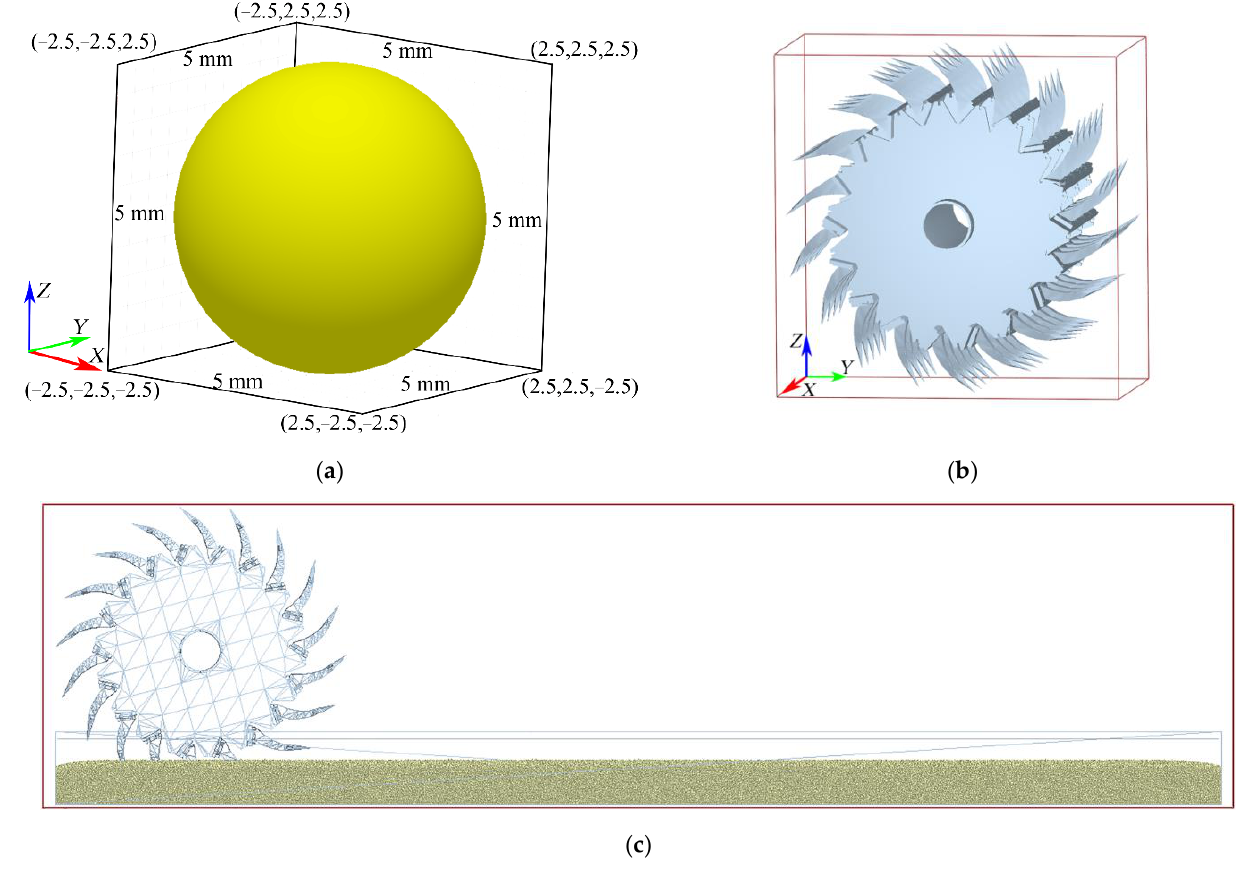
Figure 5. Particle and geometric simulation model. ( a ) Particle model of the soil; ( b ) geometric model of the tooth roller device; ( c ) simulation model of the EDEM. Table 1. Simulation parameter settings of soil particles and